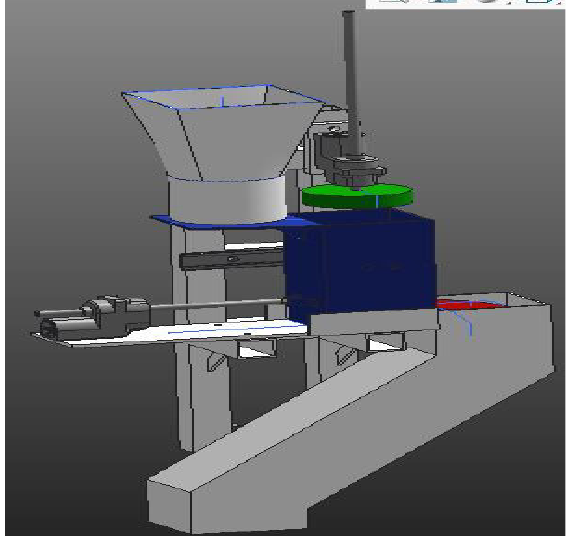
Figure 10. Crushing system Step 5. Search